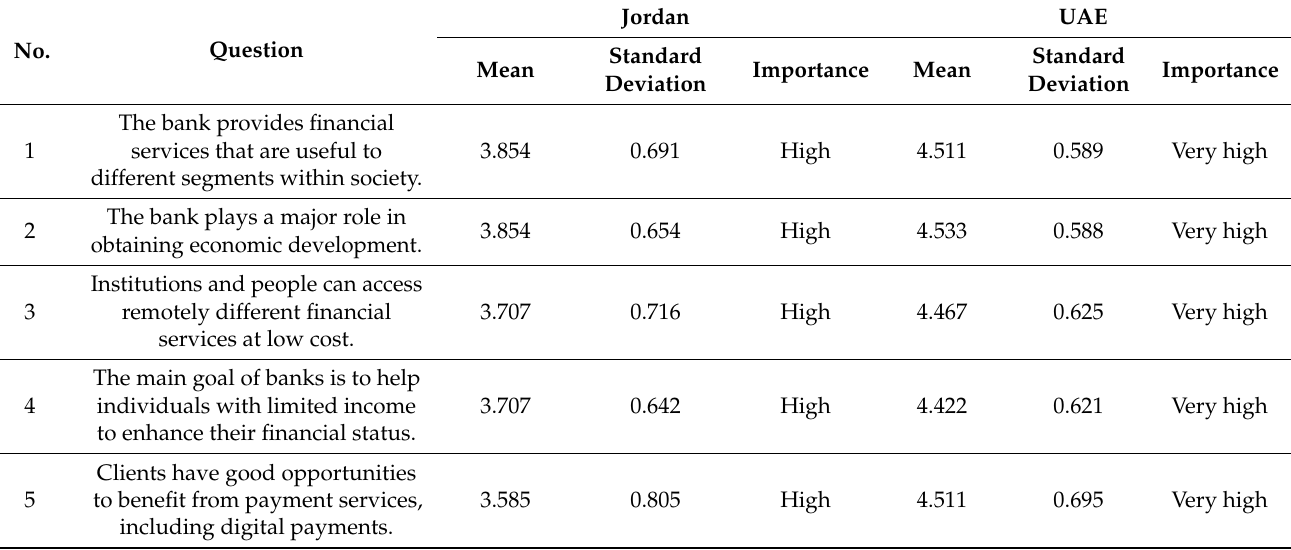
Table 2. Results of the Descriptive Analysis of the Independent Variable, Financial